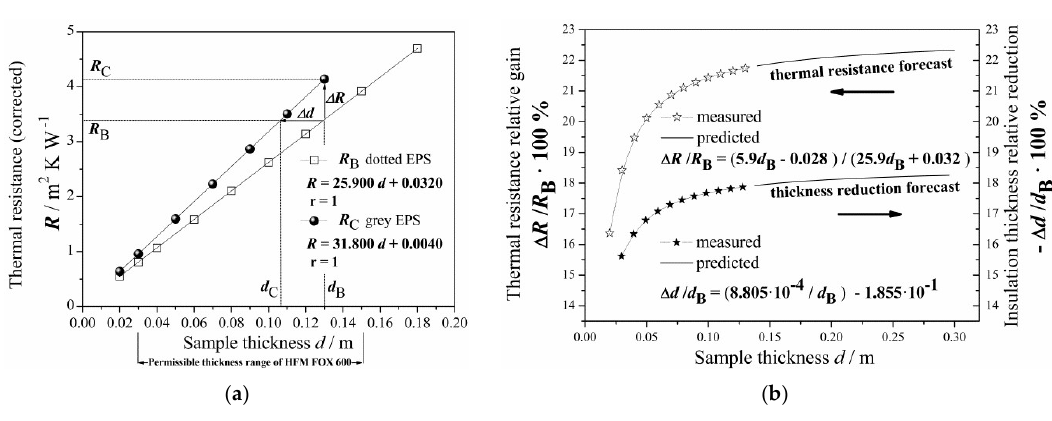
Figure 5. ( a ) The thermal resistance, R , at Tm = 10 °C versus the panel thickness d for the EPS B and C products. The equations resulting from the linear fit (1.9) from Supplementary Material part 1 are shown together with the linear correlation coefficient r (solid lines). Δ R shows the difference between B and C panels of the same thickness and Δ d shows the difference between the B and C panels of the same R -value. ( b ) The thermal resistance relative gain Δ R/RB (left axis) and the insulation thickness relative reduction −Δ d/dB (right axis) for EPS C with respect to EPS B, versus the panel thickness d . The graph is reflected horizontally, since Equation (8) gives negative values. The experimental points are extrapolated (solid lines) based on the functions shown, corresponding to Equations (9) and (11).